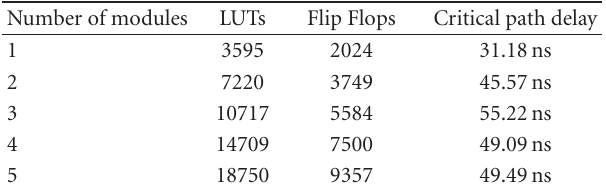
Table 1: Comparing resource use and critical path delay for various multimodule implementations.